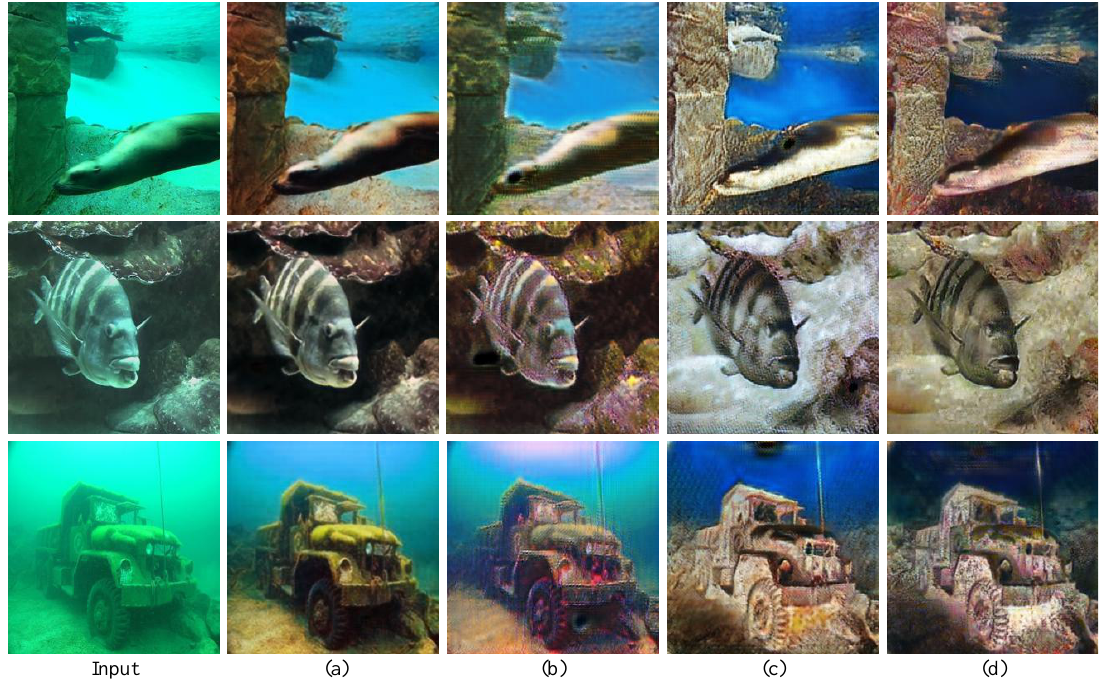
Figure 8. Underwater image enhancement results according to the feature extraction layer in the